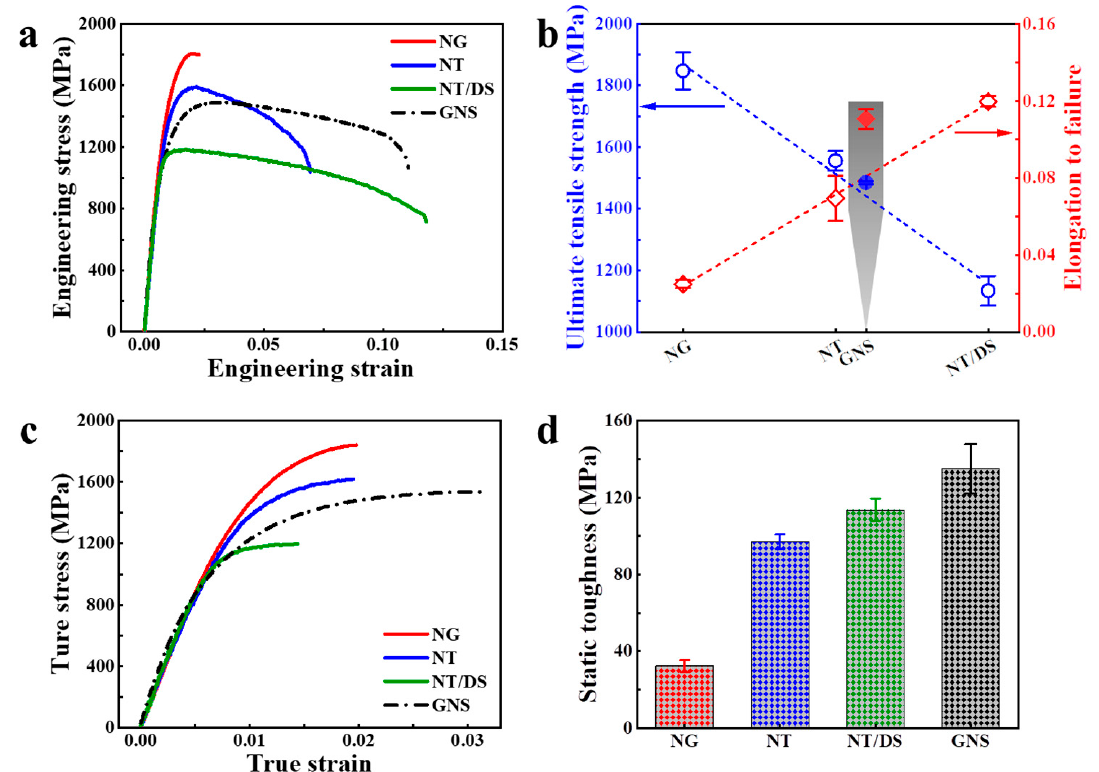
Figure 3. Comparisons between the GNS specimen and the isolated NG, NT, and NT/DS specimens: ( a ) engineering tensile stress-strain curves; ( b ) variation of ultimate tensile strength and elongation to failure; ( c ) true tensile stress-strain curves; ( d ) static toughness.